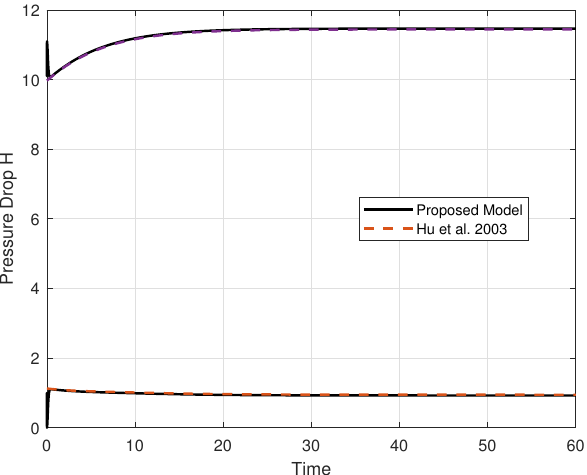
Figure 3. Model comparison on the pressure rises in the ventilation network